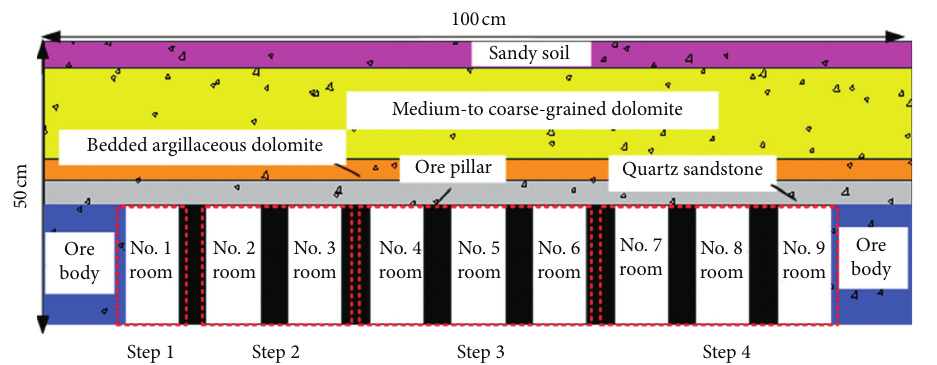
Figure 2: Mine room excavation